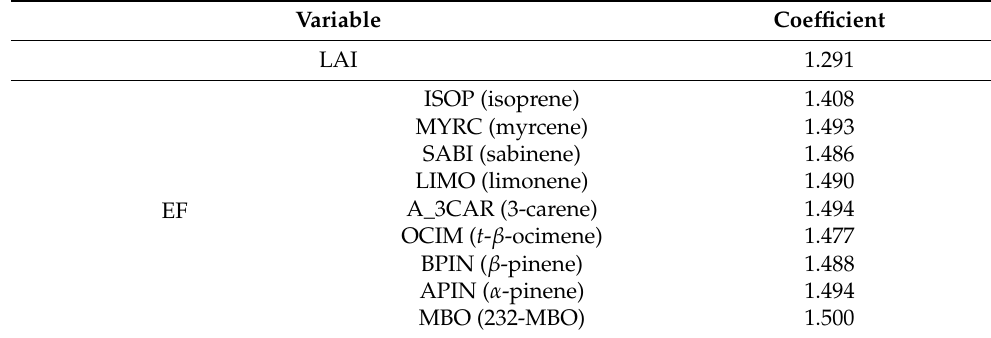
Table 1. Fitting coefficients for each variable in the carbon scenario using the ratio method. Variable